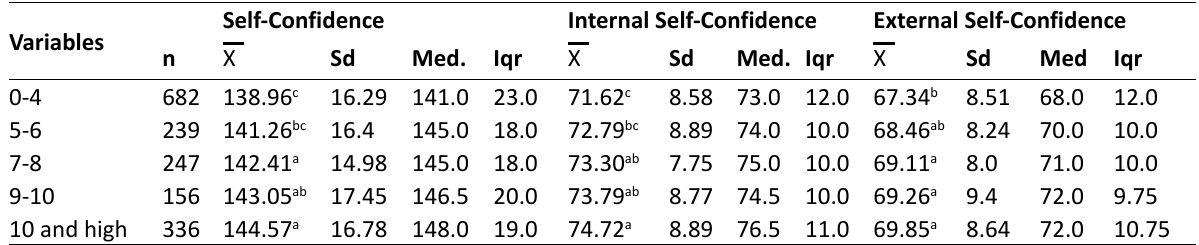
Table 3. Comparison of self-confidence and sub-dimensions according to athletes’ sport experience